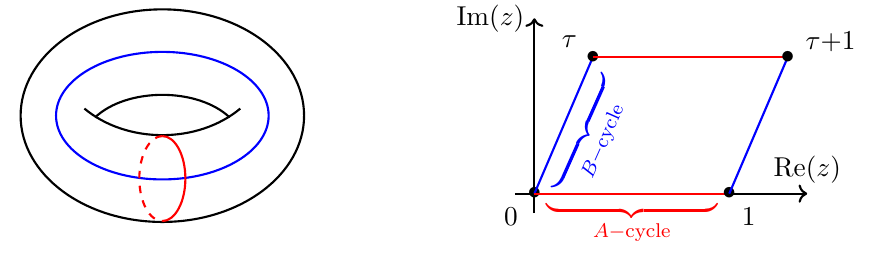
Figure 2 . The torus will be parameterized through a complex coordinate z , where the A -cycle and B -cycle translate into periodicities z (cid:24) = z +1 and z (cid:24) = z + (cid:28) ,